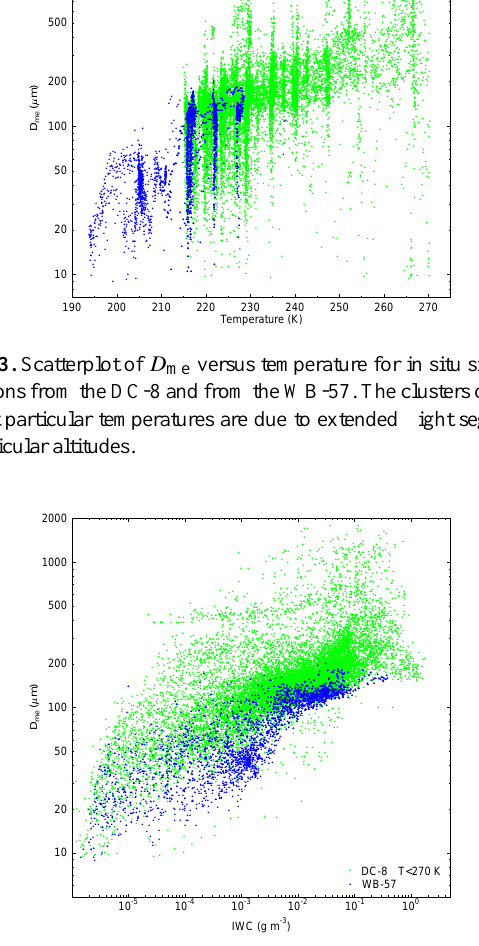
Fig. A4. Scatterplot of D me versus ice water content for in situ size distributions from the DC-8 (2D-S and PIP) and from the WB-57